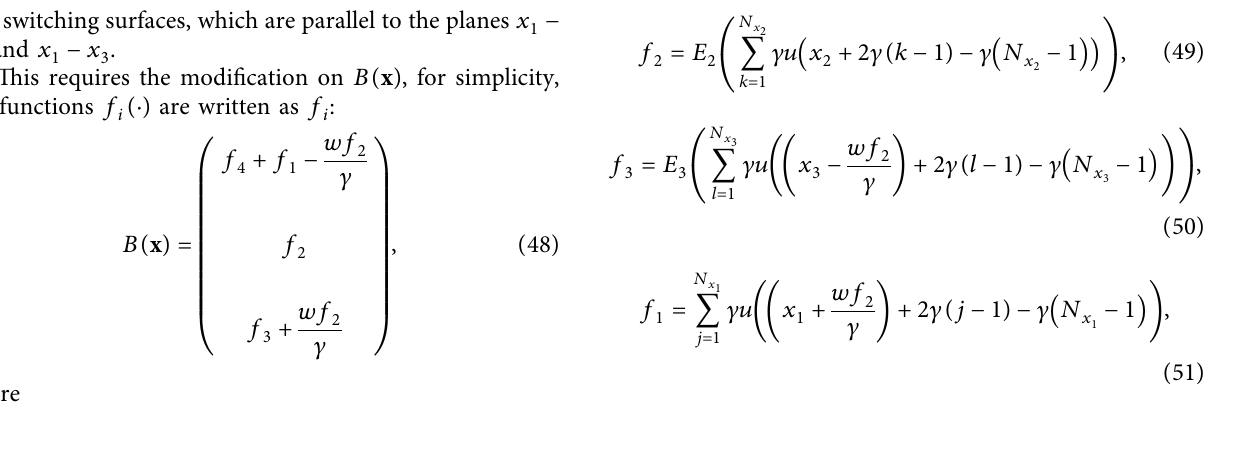
� 1 and N � 4, respectively. In (c) B ( x ) is given by (48) with x 1 x 1 � 1 ,E � 1 ,N � 2, N � 2, N � 2, and w � 0 . x 1 x 2 x 3 2 3